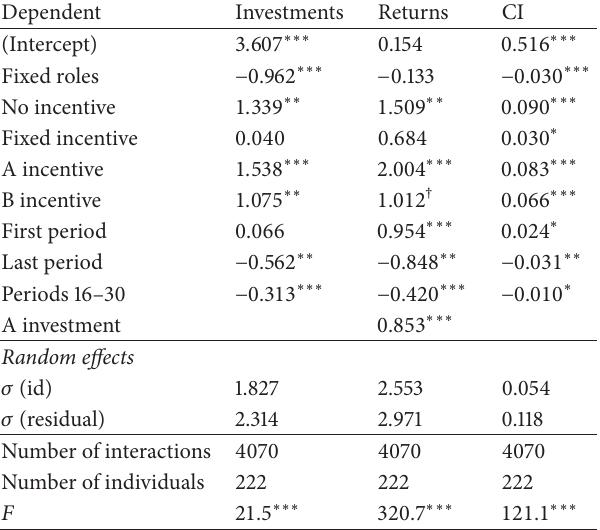
Table 1: Overview of Experiments 1 and 2 results. The AR/FR column presents the ratio between the corresponding results in the alternating and the fixed role experiment. The last two columns present Wilcoxon rank sum tests of the null hypothesis that the result distribution is the same in the two experiments.